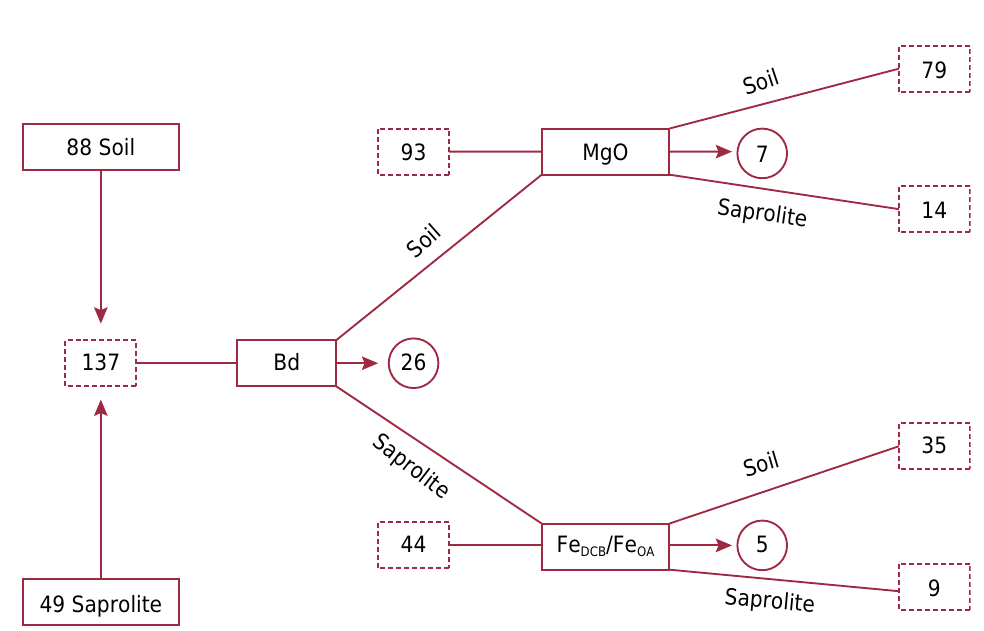
Figure 5. The decision tree output: total number of horizons/layers considered at each node (shaded rectangles), variable considered in the node (continuous rectangles) and number of horizons/layers in disagreement